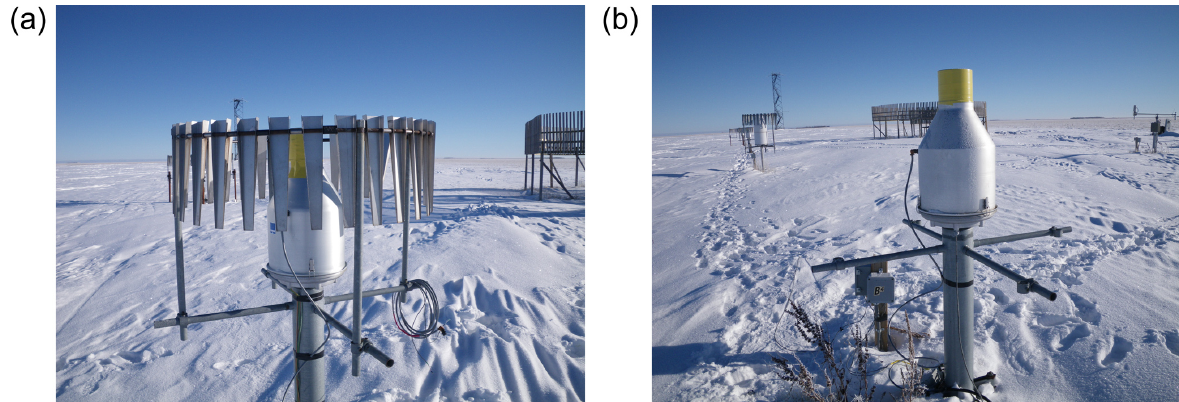
Figure 2. The SPICE Alter-shielded (a) and unshielded (b) Geonor T-200B gauge pair at Bratt’s Lake.